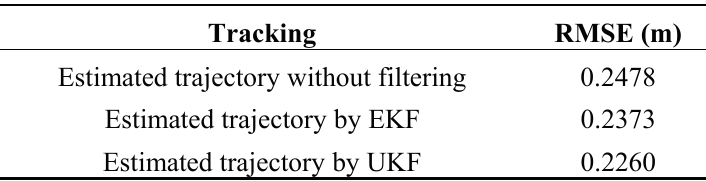
Figure 9. Tracking of a target in two-dimensional coordinates. Table 5. RMSE comparison between the estimated target trajectories with filters and the true target